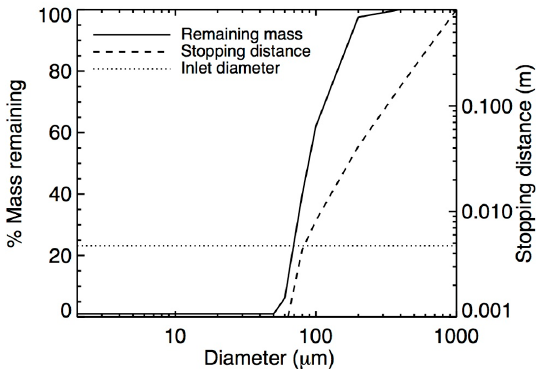
Fig. 2. Absorption spectrum as recorded by CLH-2, showing a sin- gle observed scan. This includes the dark voltage observations at steps 1 to 40, and the wavelength scan (steps 40 to 512) with the prominent absorption feature centered at about step 250. The fitted baseline provides an estimate of the detector output were no absorp- tion to occur.